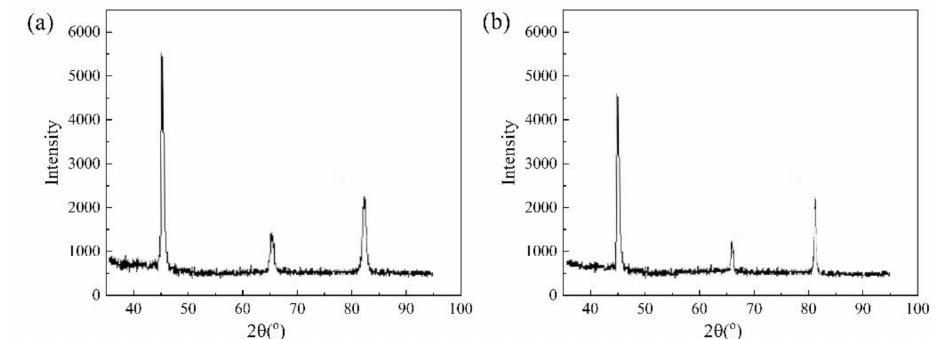
Figure 5. The X-ray diffraction patterns of the specimen that experienced fatigue tests of 450 MPa for 10,000 cycles under magnetic field of 1.2–1.3 T ( a ) or no magnetic field ( b